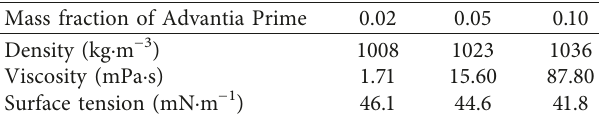
Table 3: Rheological properties of the Advantia Prime coating solution.